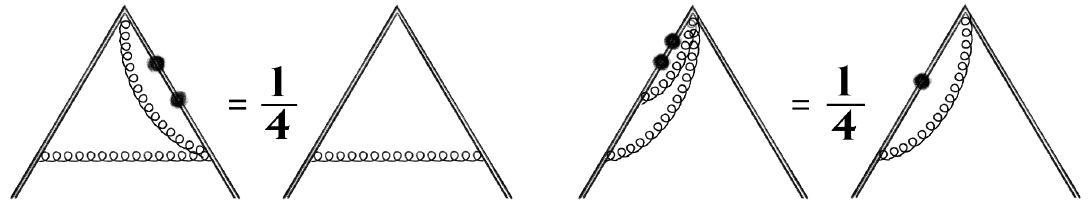
Figure 3. Relations between admissible integrals of different loop